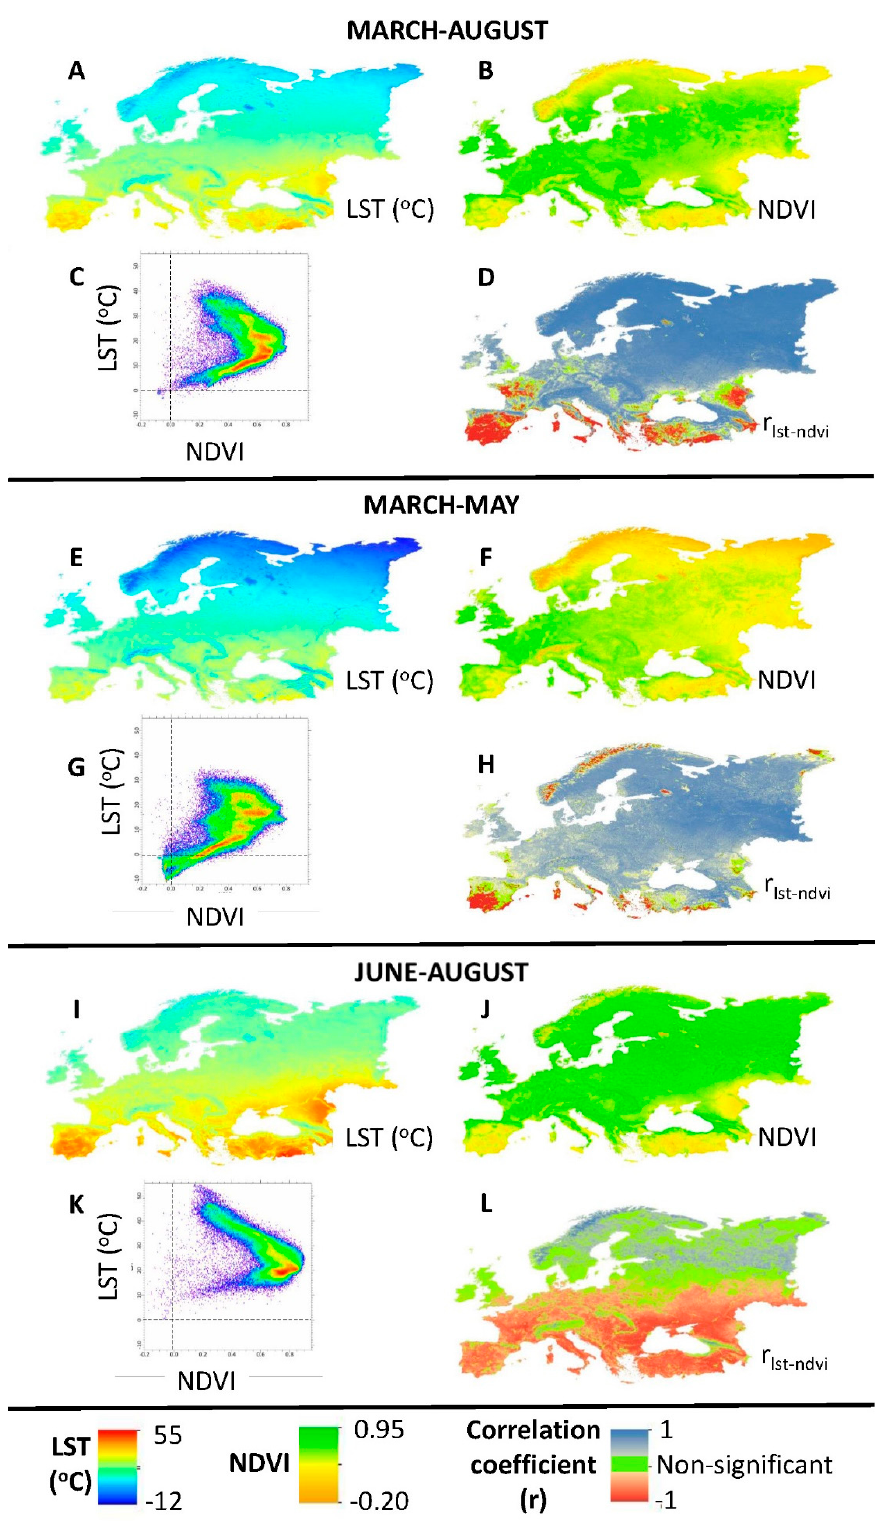
Figure 2. ( A , E , I ) Average land surface temperature (LST) from March–August, March-May, and June–August, respectively; ( B , F , J ) Average normalized difference vegetation index (NDVI) for the respective periods; ( C , G , K ) LST–NDVI scatterplots for the respective periods; ( D , H , L ) Correlation coefficients for LST and NDVI for the respective periods.